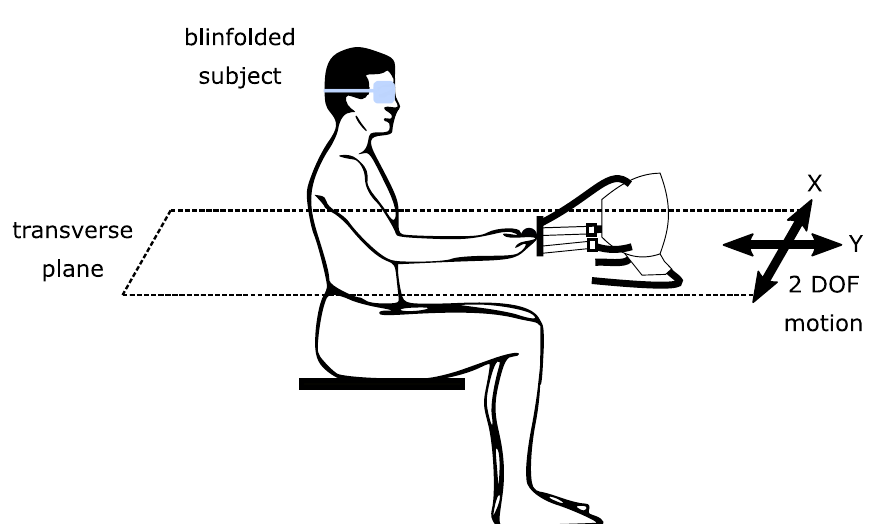
Figure 3. Experimental conditions during haptic exploration.